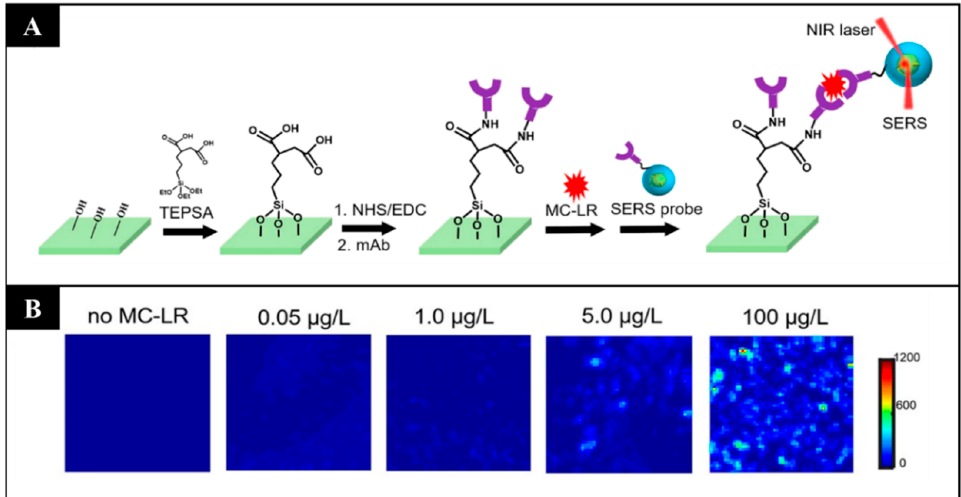
Figure 4. ( A ) Schematic representation of microcystin-LR (MC-LR) detection by an immunosensor and SERS probe. ( B ) Representative SERS images for increasing concentrations of the biotoxin. (Reproduced with permission [98], Copyright 2019, American Society of Chemistry).